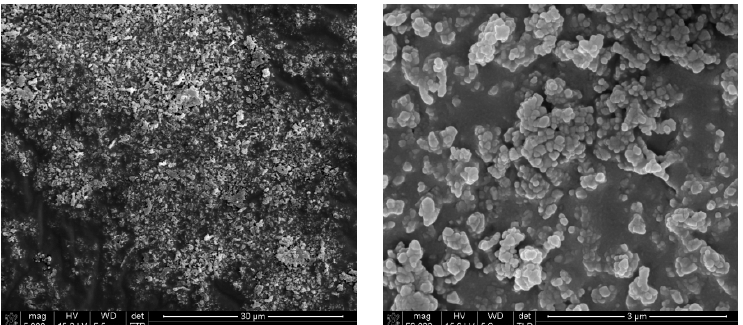
Figure 7. Micrographs of cryo-granulated yttria obtained by solution combustion synthesis through the reaction of yttria nitrate with glycine calcined at a temperature of 1100 °C after milling for 15 min in an attritor mill at a speed of 1000 rpm.